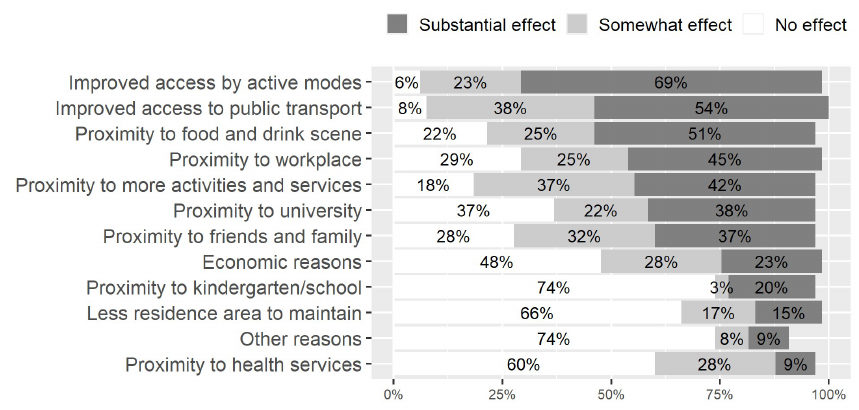
Figure 1. The assessed effect of each aspect on preferences for centralization (n = 63).